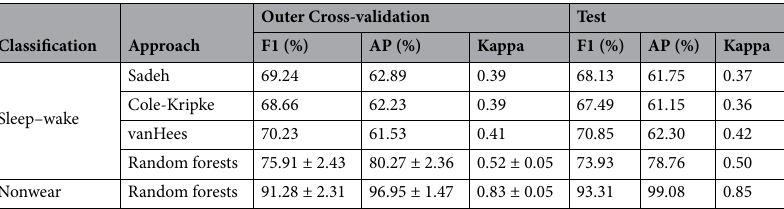
Table 2. Binary sleep–wake and nonwear–wear classification. F1 F1-score, AP average precision (mean ± standard deviation).